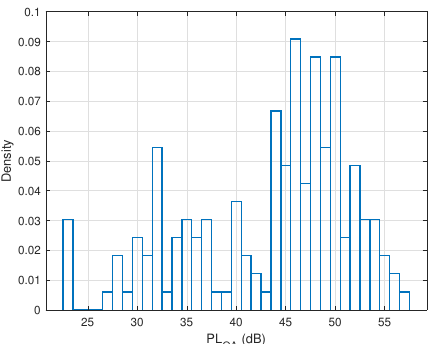
Figure 4. The probability histogram of the trial indoor walking